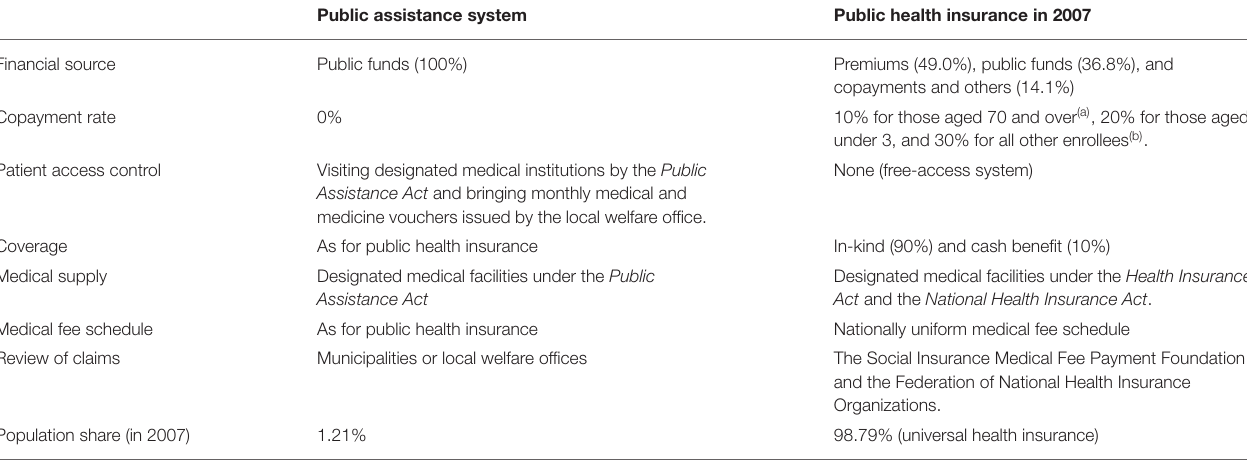
TABLE 1 | Institutional differences in healthcare use between the public assistance and universal public health insurance systems in